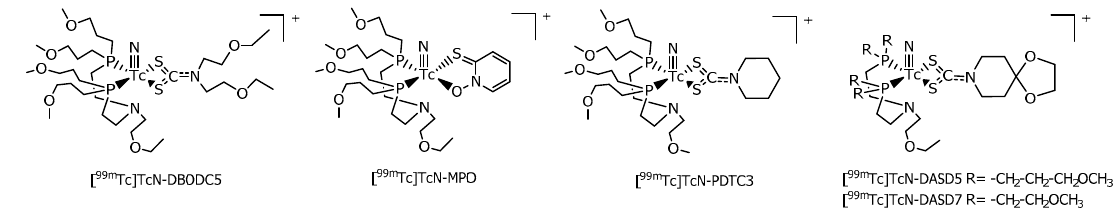
Figure 12. Structures of the most representative [ 99m Tc][TcN(PNPn)]-based MPIAs.